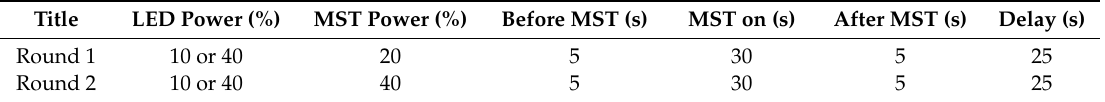
Table 2. Instrument settings for MST